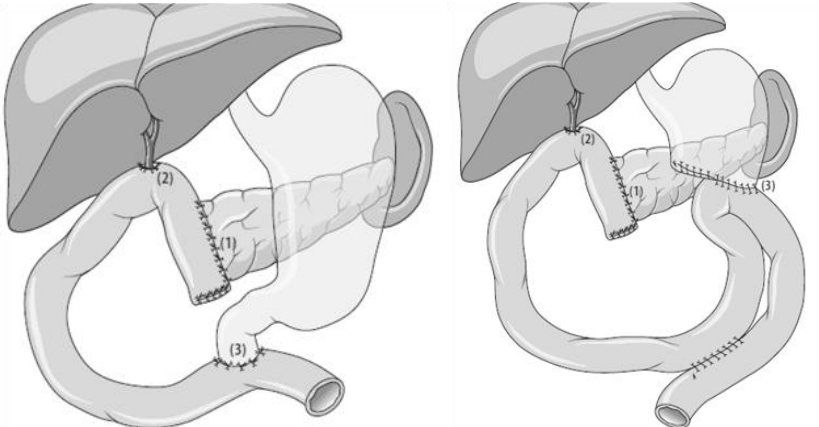
Figure 1. Pylorus-preserving (left) and classical (right) pancreatico-duodenectomy. End- to-side pancreatico-jejunostomy (1), end-to-side hepato-jejunostomy (2) and end-to-side duodeno- or gastro-jejunostomy (3), respectively.